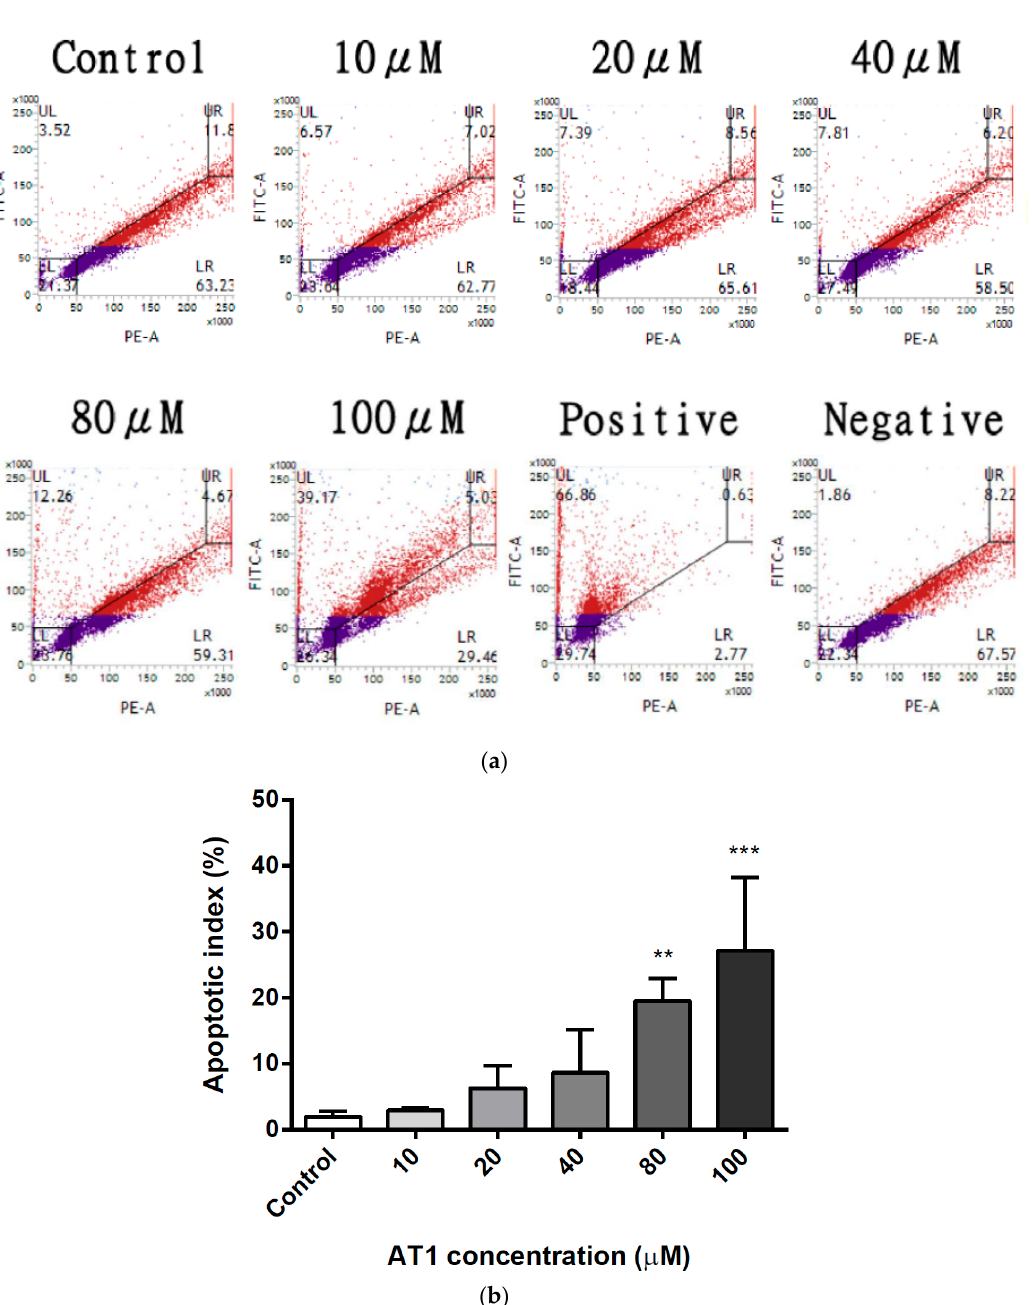
Figure 4. The e ff ects of various concentrations of AT-I on apoptotic DNA fragmentation in HT-29 cells were assessed using the TUNEL assay and flow cytometry. Cells were treated with AT-I for 48 h and analyzed using flow cytometry. The control group was not treated with AT-I. ( a ) A dot plot to represent the number of events with fragmented DNA after treatment with various AT-I concentrations, as well as positive and negative controls. This is a representative of three independent experiments. ( b ) A bar chart to present the apoptotic index after treatment with various AT-I concentrations. Data are shown as mean ± SD, n = 3. Significant di ff erences are indicated by ** p < 0.01 and *** p < 0.001 as compared with the control